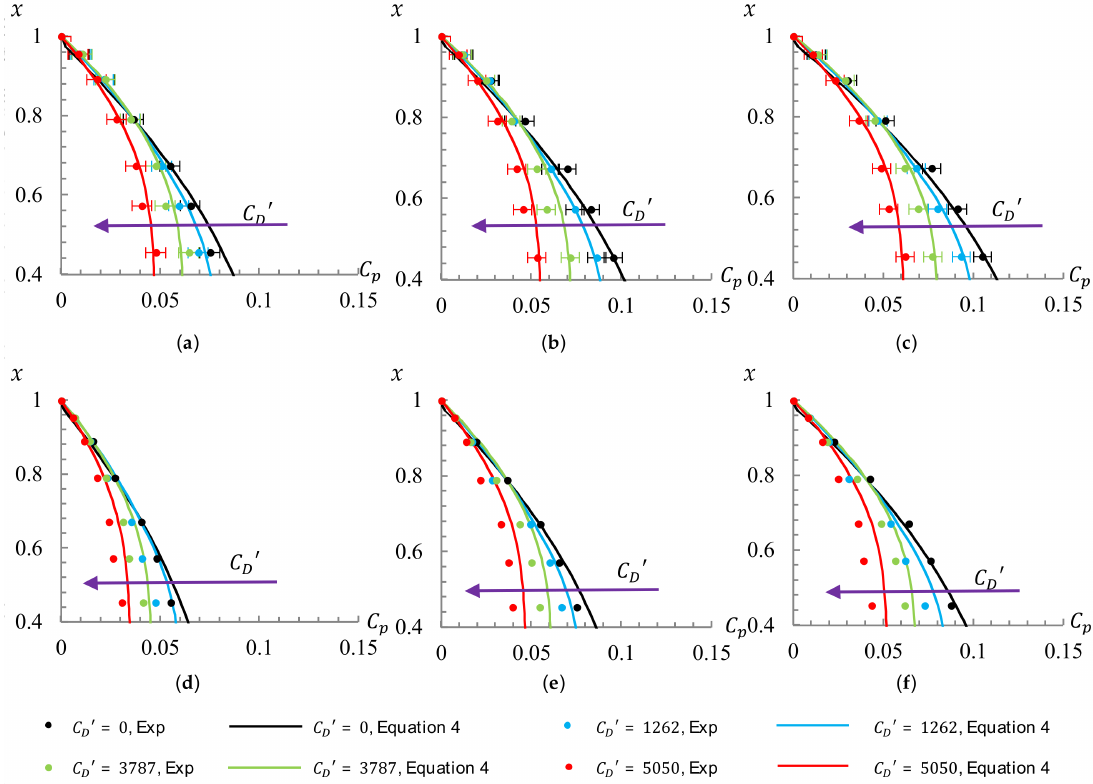
Figure 11. Distribution of C p along the non-dimensional radius of the disk: ( a ) Re = 0.76 × 10 6 , G = 0.072; ( b ) Re = 0.76 × 10 6 , G = 0.036; ( c ) Re = 0.76 × 10 6 , G = 0.018; ( d ) Re = 2.79 × 10 6 , G = 0.072; ( e ) Re = 2.79 × 10 6 , G = 0.036; ( f ) Re = 2.79 × 10 6 , G = 0.018. C D (cid:48) : through-flow coefficient; C p : pressure coefficient; G : non-dimensional axial gap; x : non-dimensional radial